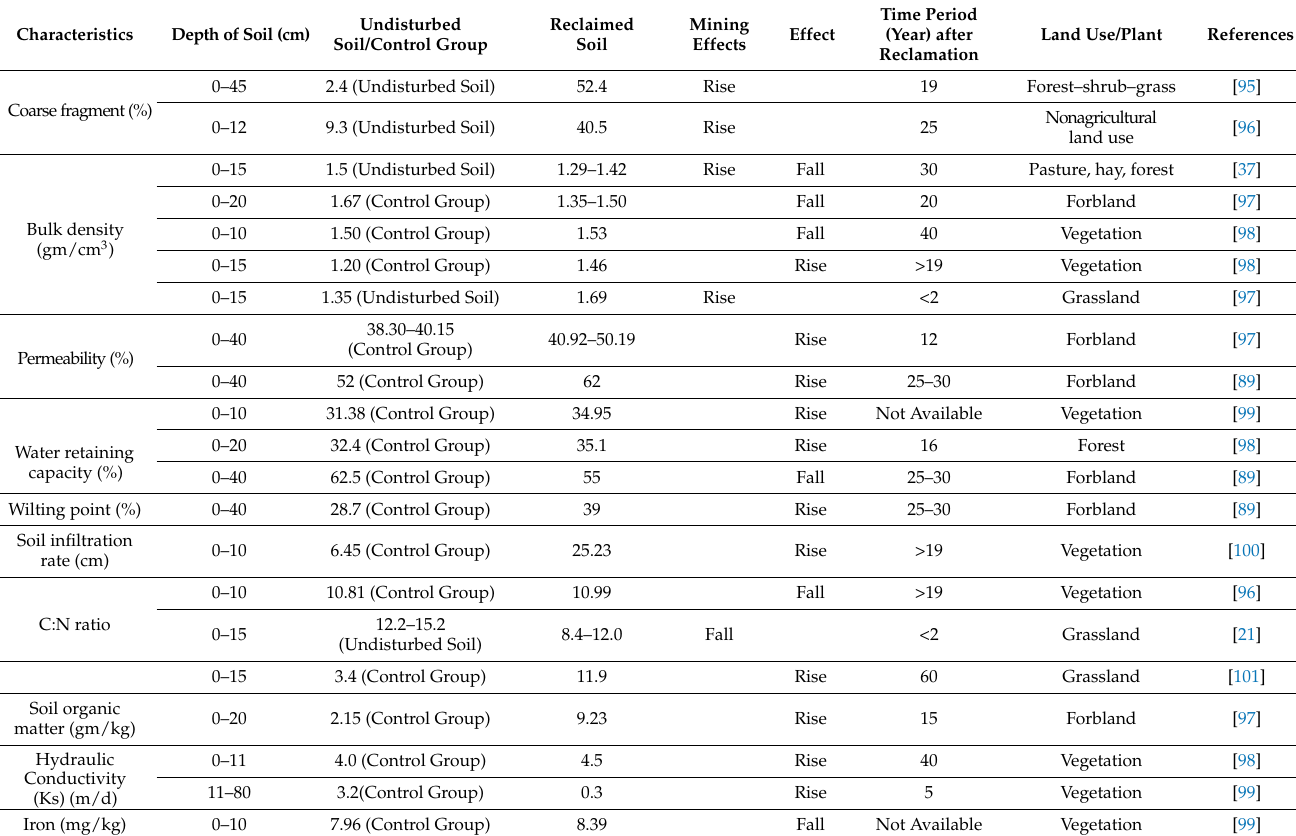
Table 1. Effect of reclamation process and mining on soil